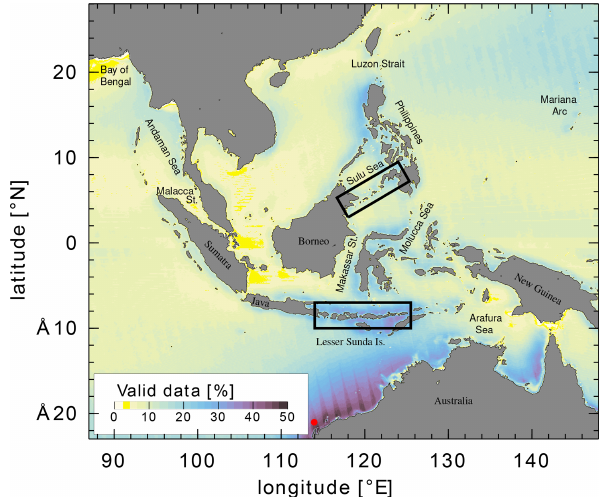
Figure 1. The percentage of valid Chl a observations per pixel in the Level-3 GlobColour daily MODIS product. The rectangular boxes indicate regions enlarged in subsequent figures. The maximum pos- sible observation count, if there were no data gaps, is 7264 for the time period of the observations (July 2002 to August 2022). The red marker at 21 ◦ S, 114 ◦ E indicates the location of the time series used for Fig.